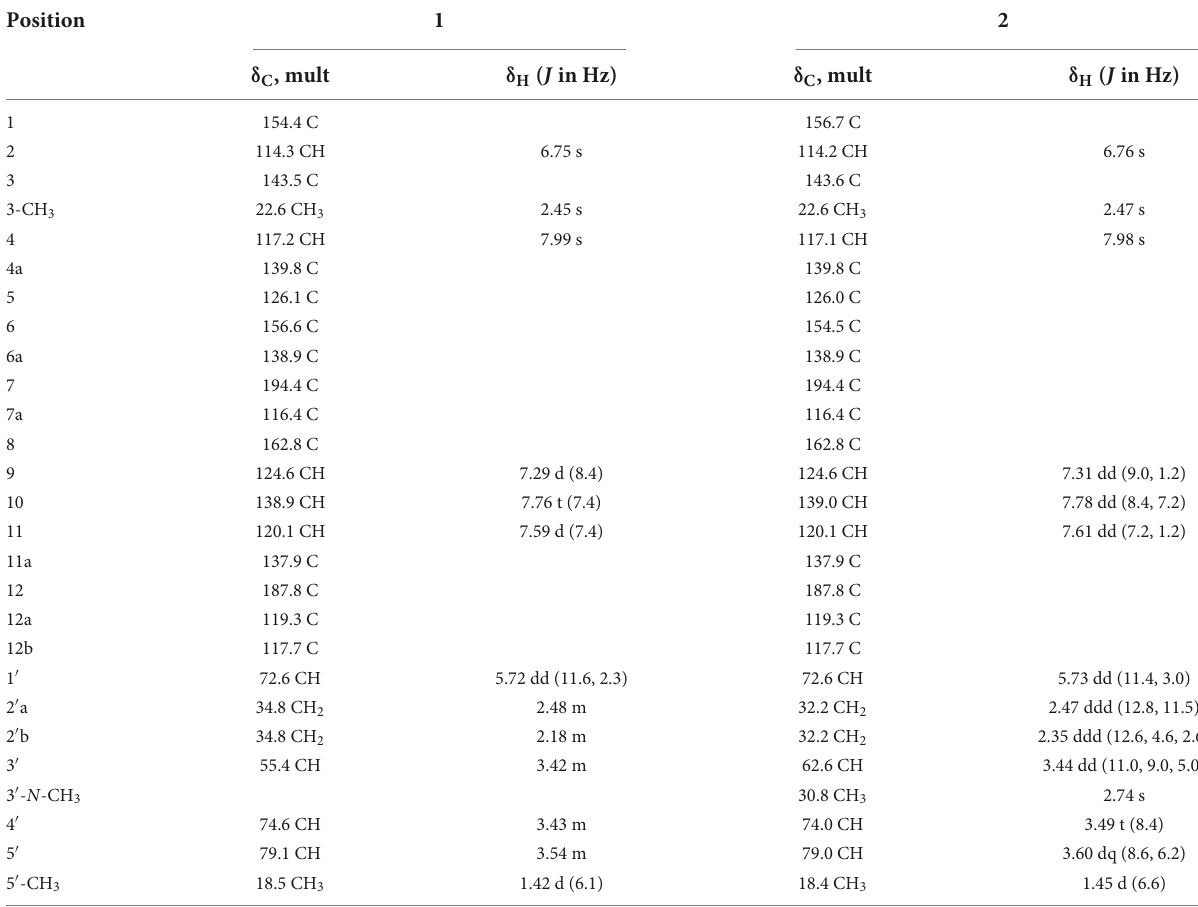
TABLE 1 1 H (600 MHz) and 13 C (125 MHz) NMR spectroscopic data of 1 and 2 in CD 3